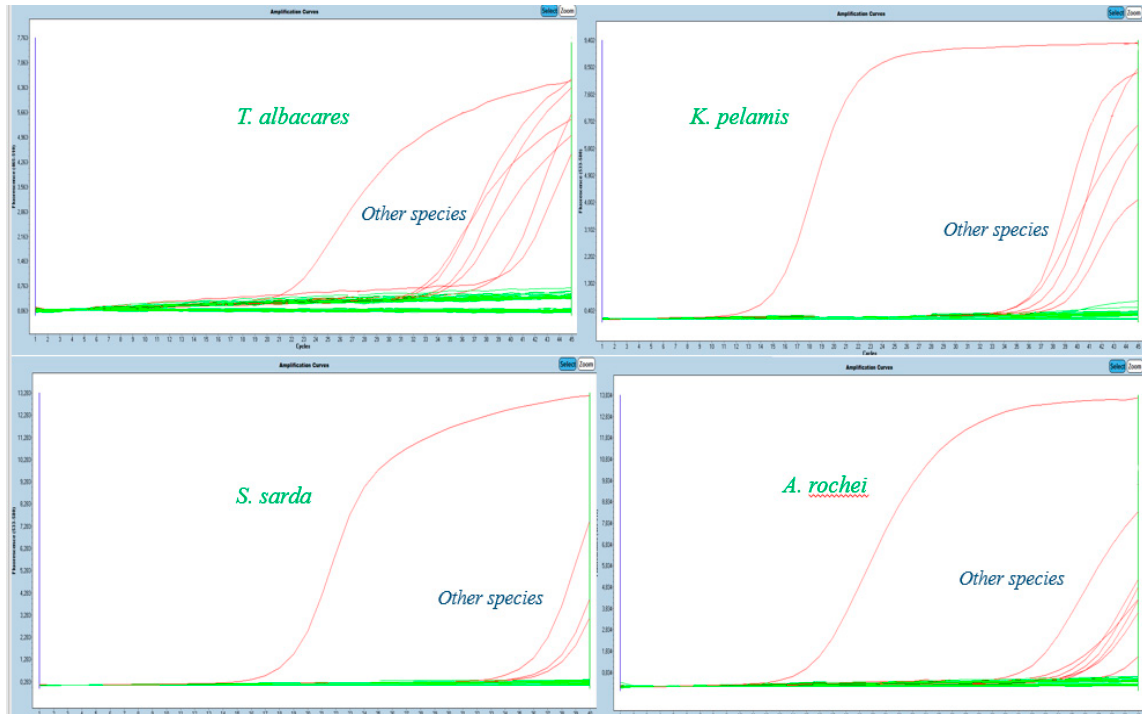
Figure 1. Specificity for different tuna species.